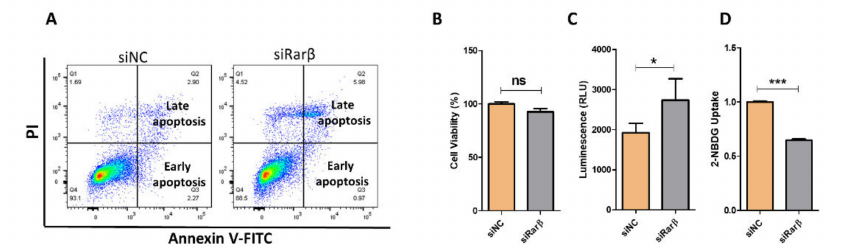
Figure 3. Impact of siRar β on apoptosis, ROS production, and glucose uptake. ( A ) Apoptosis levels in Rar β -silenced cells compared to negative control cells are determined by flow